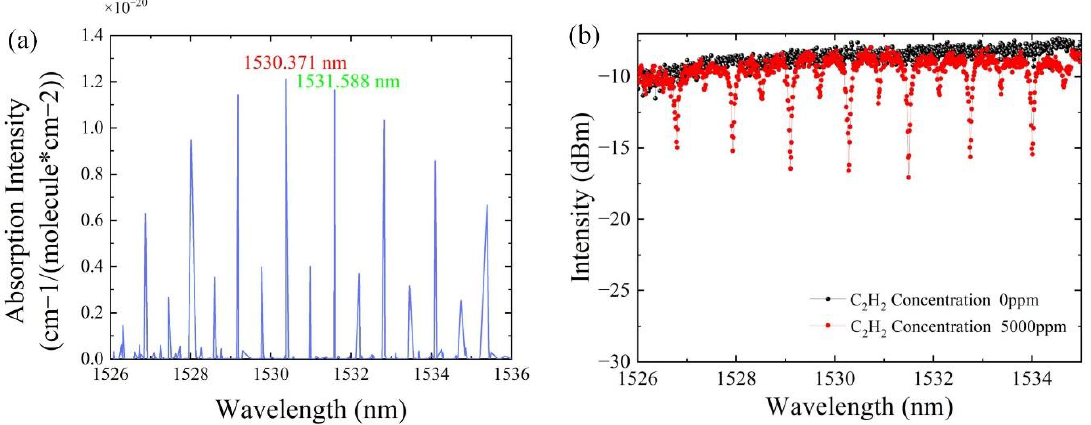
Figure 3. ( a ) Absorption intensity of acetylene in Hytran database, and ( b ) the absorption intensity measured by experiment.